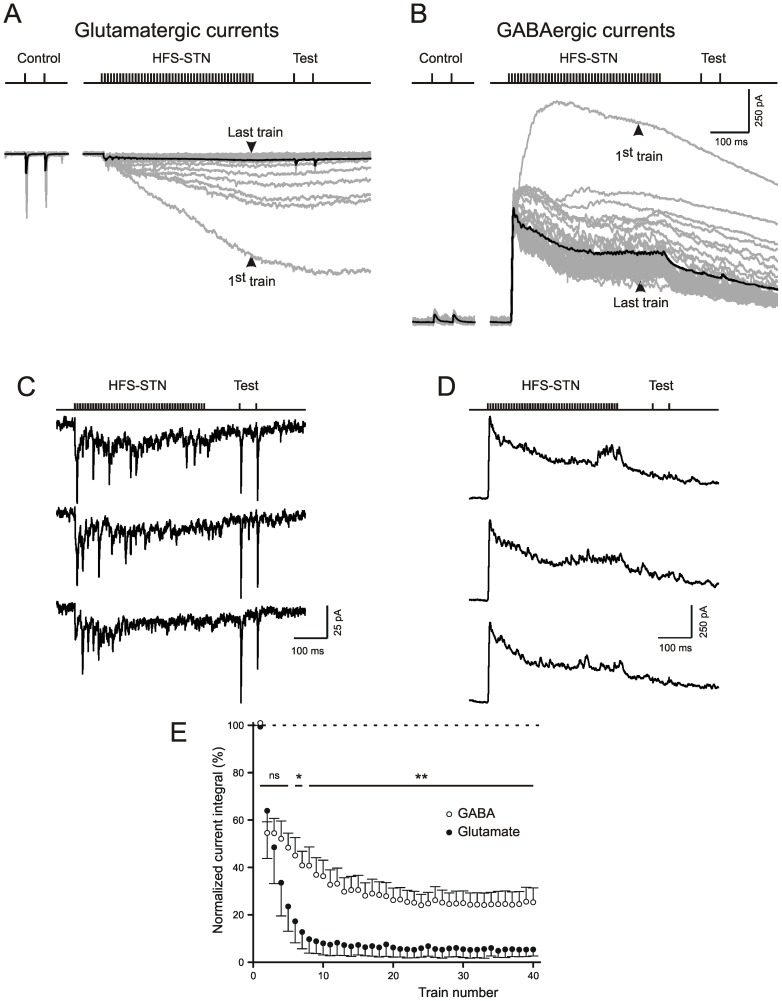
Compound glutamate- and GABA-induced ion currents during and after multi-unit HFS-STN.Responses of SNr neurons to Macrostim in the STN. Note that the driving force for the transmitter-induced currents is 60 mV for glutamate but only 50 mV for GABA. A) Recordings in the presence of gabazine (15 µM) to show compound glutamatergic ion currents. The calibration bars in (B) also apply to (A). Note strong attenuation with train repetition. B) Recordings in the presence of DNQX (10 µM) and APV (50 µM). Note that a fraction of the GABA-induced chloride current remains during and after HFS-STN. C,D) Enlarged individual traces from same experiments as in A,B, respectively. Shown are the last 3 trials of an HFS-STN conditioning session. The glutamatergic responses are strongly attenuated, GABAergic currents persist. E) Plot of current integrals during individual HFS-STN trials against trial number. The responses are normalized to the current integral during the first train (only cells with integral values >25 pA*s during first train included).